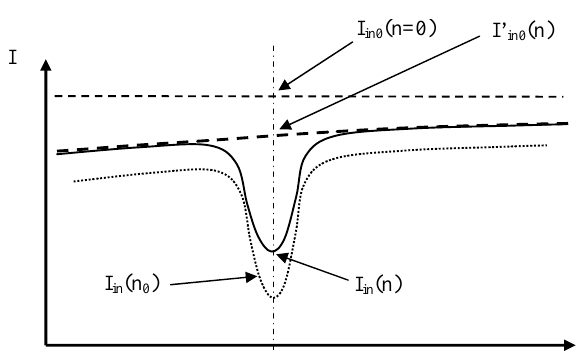
Fig. 1: Sketch of intensities vs. wavelength: Fig. 1. Sketch of intensities vs. wavelength: I in0 ( n 0 ): intensity (af- ter n 0 passes through the cavity) in the pure air filled cavity without any absorbers, I’ in0 ( n ): intensity (after n passes through the cavity) after any continuous absorption (due to gases or aerosol) has taken place. I in ( n ): Intensity after n passes through the cavity includ- ing also differential absorptions (note that n varies with wavelength since the trace gas absorption cross section varies with wavelength). I in (n 0 ): Theoretical intensity for the same absorptions if the num- ber of traverses were not